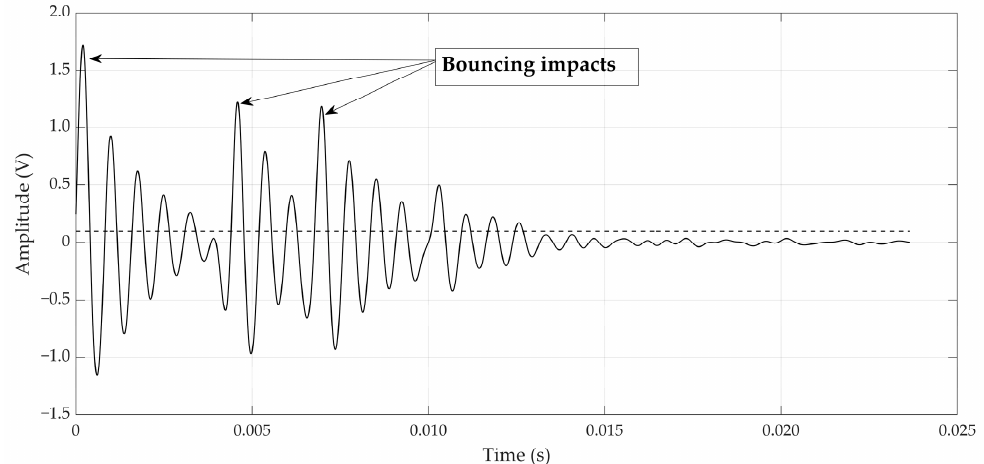
Figure 2. Typical impact data retrieved from the microphone. The dashed line gives the threshold value used to define contact time.